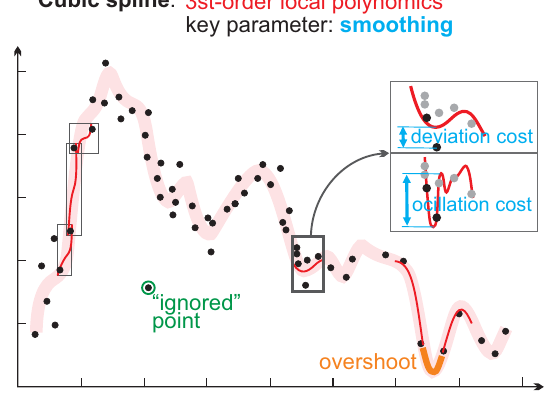
Figure 7. Cubic smoothing spline principles. Black points are the source data; red narrow lines are the local spline solutions; the thick rose line is a global spline solution for the smoothing parameter 0.05 (schema based on a real modeling).